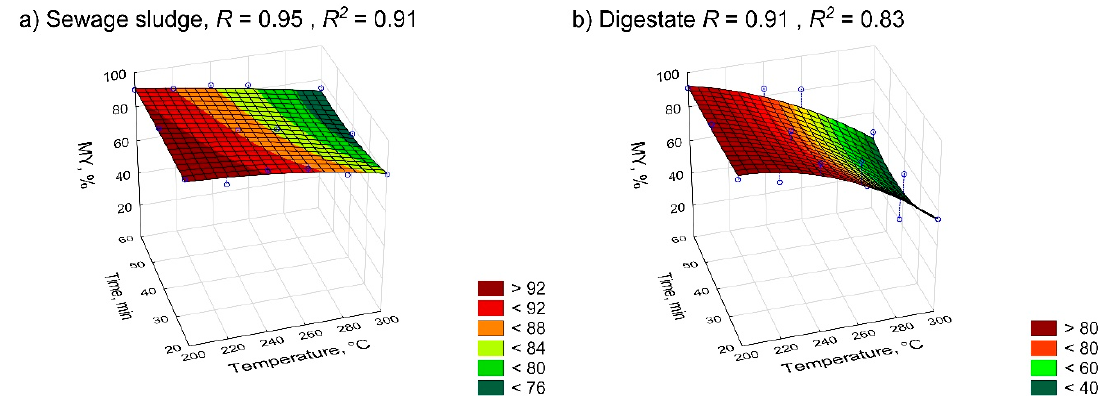
Figure 4. The influence of torrefaction temperature and residence time on the mass yield of CSF from ( a ) sewage sludge and ( b ) digestate. R —correlation coe ffi cient; R 2 —determination coe ffi